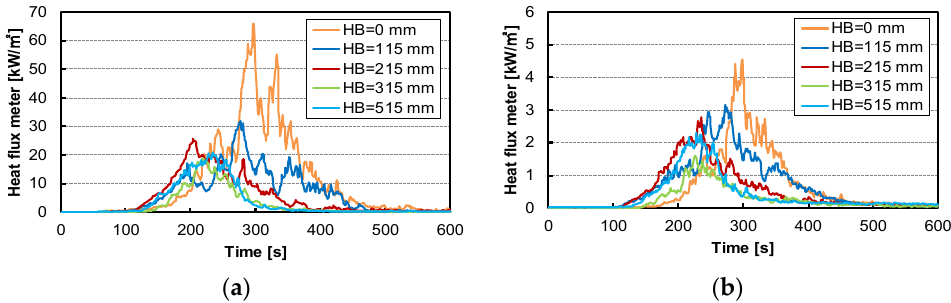
Figure 6. Heat flux measured by the heat flux meters installed at the same height as the top surface of mattress with the measuring surface turn-up at the position of ( a ) 0.2 m and ( b ) 1.0 m away from the side of mattress.